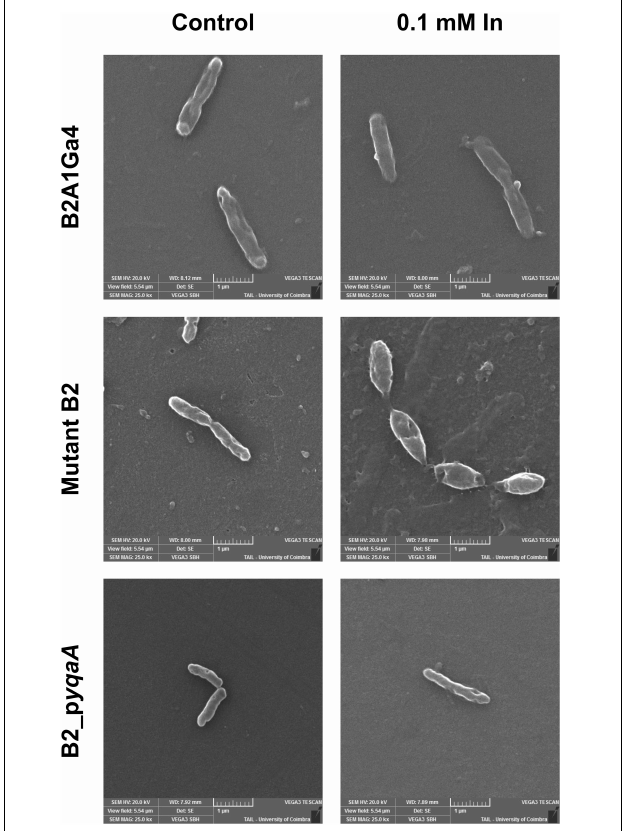
FIGURE 8 | Representative SEM micrographs (magnification of 25,000 × ) of the different strains, B2A1Ga4, mutant B2, and B2_p yqaA , grown with and without 0.1 mM